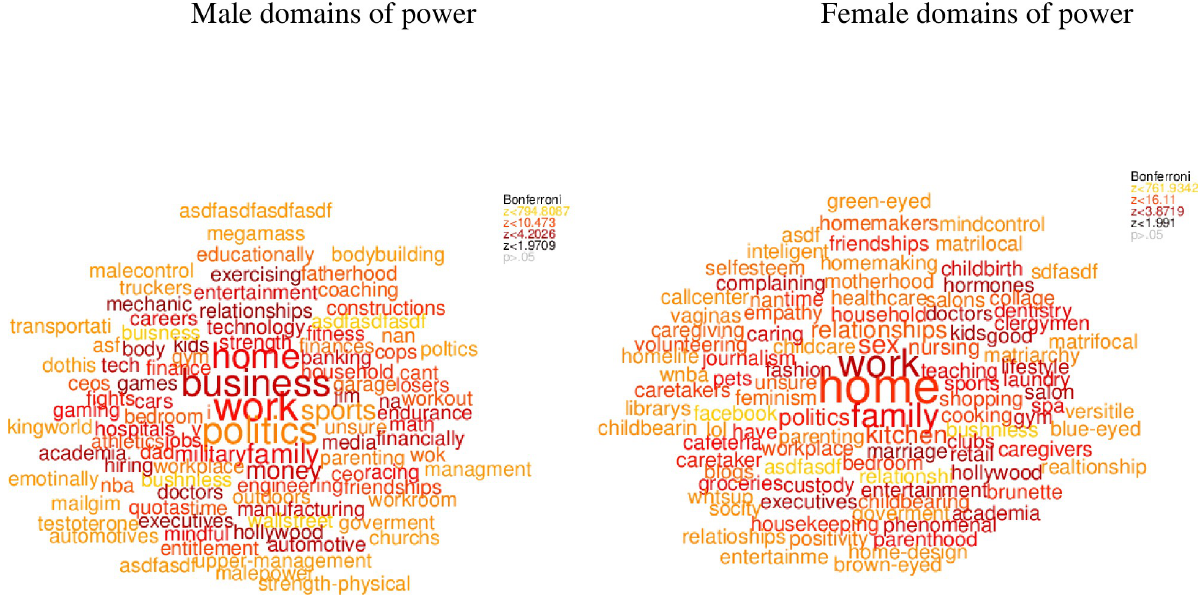
Fig 3. Word clouds describing domains of female and male power. Note . The figures were created using the same method as in Fig 1, and based on word data answering the semantic questions “Please write five keywords describing domains where men have power” (left panel) and “Please write five keywords describing domains, where female have power” (right panel) were the semantic similarity, was quantified in relation to a random set of words from Google